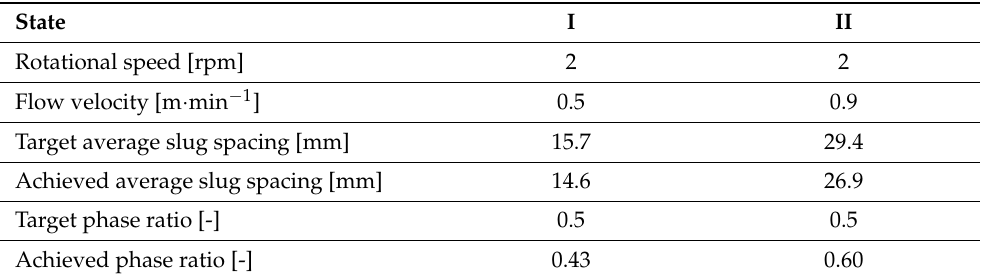
Table 4. Characteristic sizes of the modified